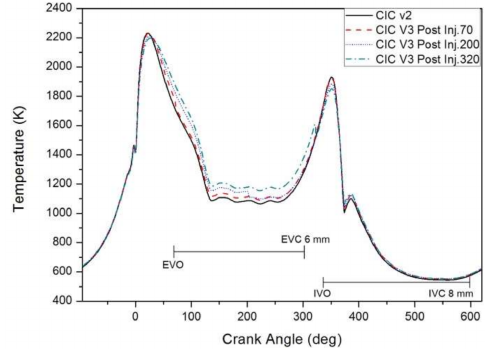
Figure 10. Temperature variation for different recompression strategies with three post